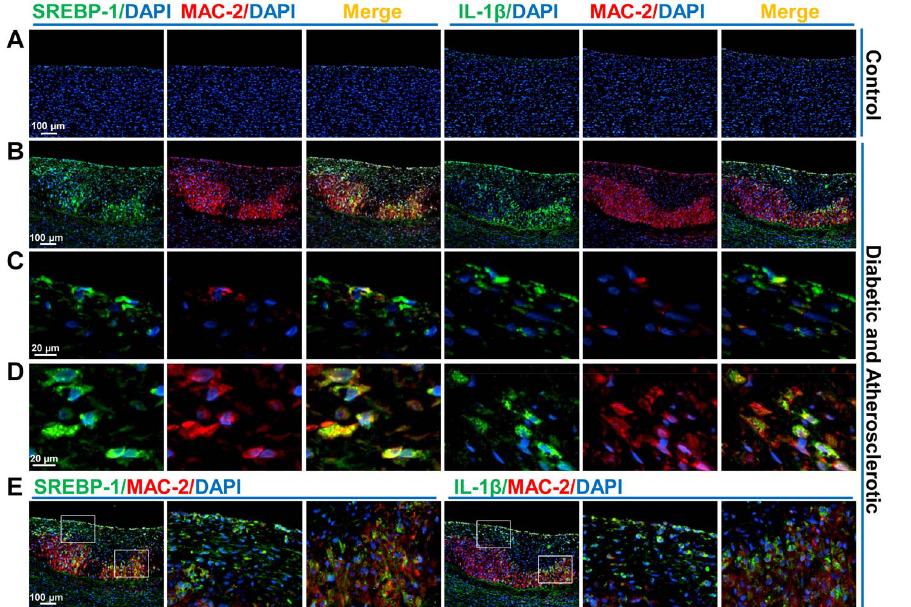
Figure 8. Immunofluorescent double staining for SREBP-1 and MAC-2 as well as for IL-1 b and MAC-2 in aortic sections of control pigs and diabetic, atherosclerotic pigs. A representative immunofluorescence staining of adjacent aortic sections of control pigs ( A ) and diabetic, atherosclerotic pigs ( B–E ) is shown. Scale Bars: 100 m m or 20 m m. A . Immunofluorescent staining for SREBP-1 (green), IL-1 b (green), or MAC- 2 (red), and nuclear staining of DAPI (blue) in control pig aorta is shown. B . The staining for either SREBP-1 (left panel) or IL-1 b (right panel) is detected in endothelial and smooth muscle layers as well as in MAC-2 positive macrophages of atheromatous plaques. C . positive cells of SREBP-1 or IL-1 b are present in endothelial layers within lesions. D . Double staining-positive cells (yellow) either for SREBP-1 and MAC-2 or for IL-1 b and MAC-2 are also located primarily in macrophage-rich regions within the subendothelial and intimal lesions. E . The regions representing an endothelium/ intimal lesion area and a macrophage-rich core plaque area, respectively, are selected and presented as the enlarged images, so that the different cell types involved in the role of SREBP and IL-1 b within lesions can be clearly observed.